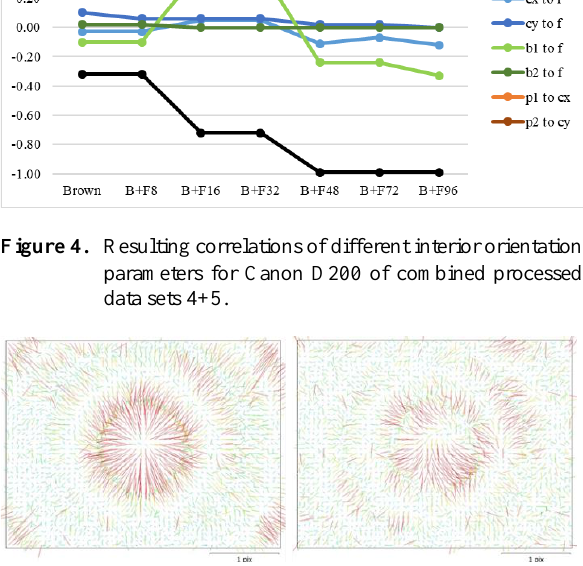
Figure 5. Residual plots from Agisoft Metashape with B and B+F96 for DJI FC220 (data set 4); vector scale 1000.